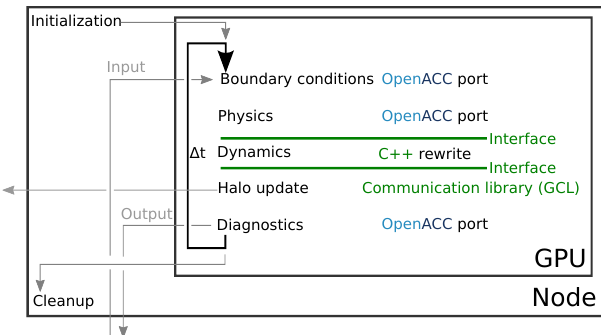
Figure 1. Workflow of the COSMO model on GPUs. Boundary conditions, physics, diagnostics and I/O have been ported using OpenACC (blue). Dynamics and Halo updates have been rewritten in C++ (green).